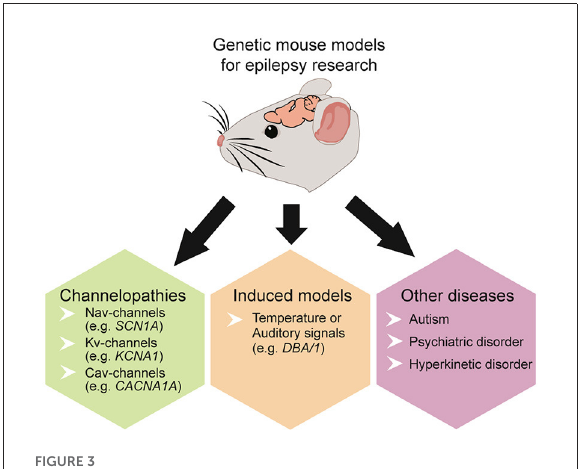
FIGURE3 Overview of commonly used genetic mouse models to study epilepsy, SUDEP, and co-existing disorders.